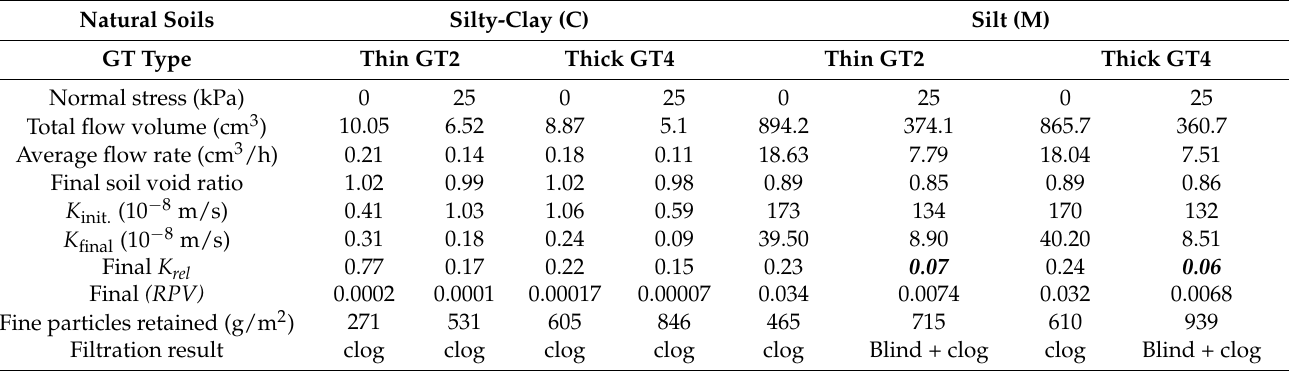
Table 9. Summary of the operational data and gradient ratio filtration test results at 48